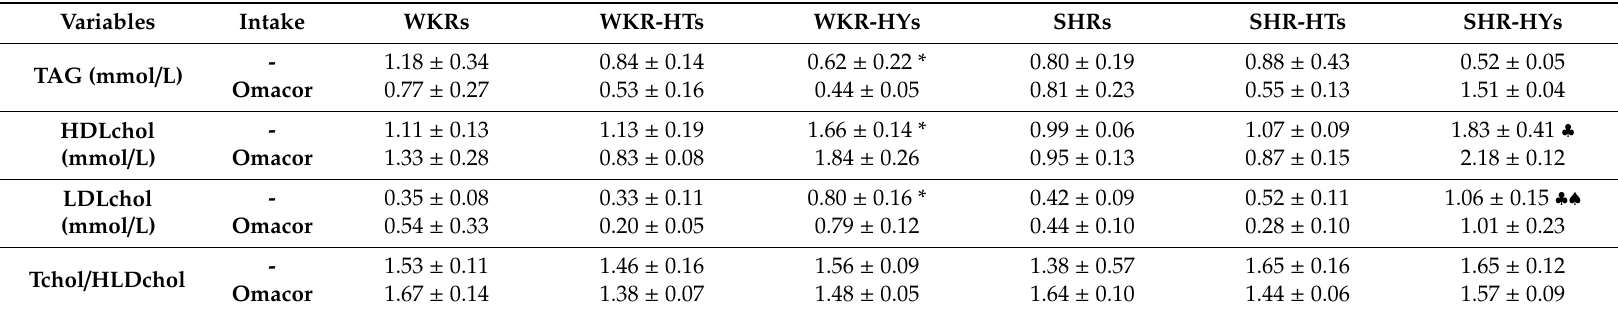
Table 2. Lipid profile of experimental rats.